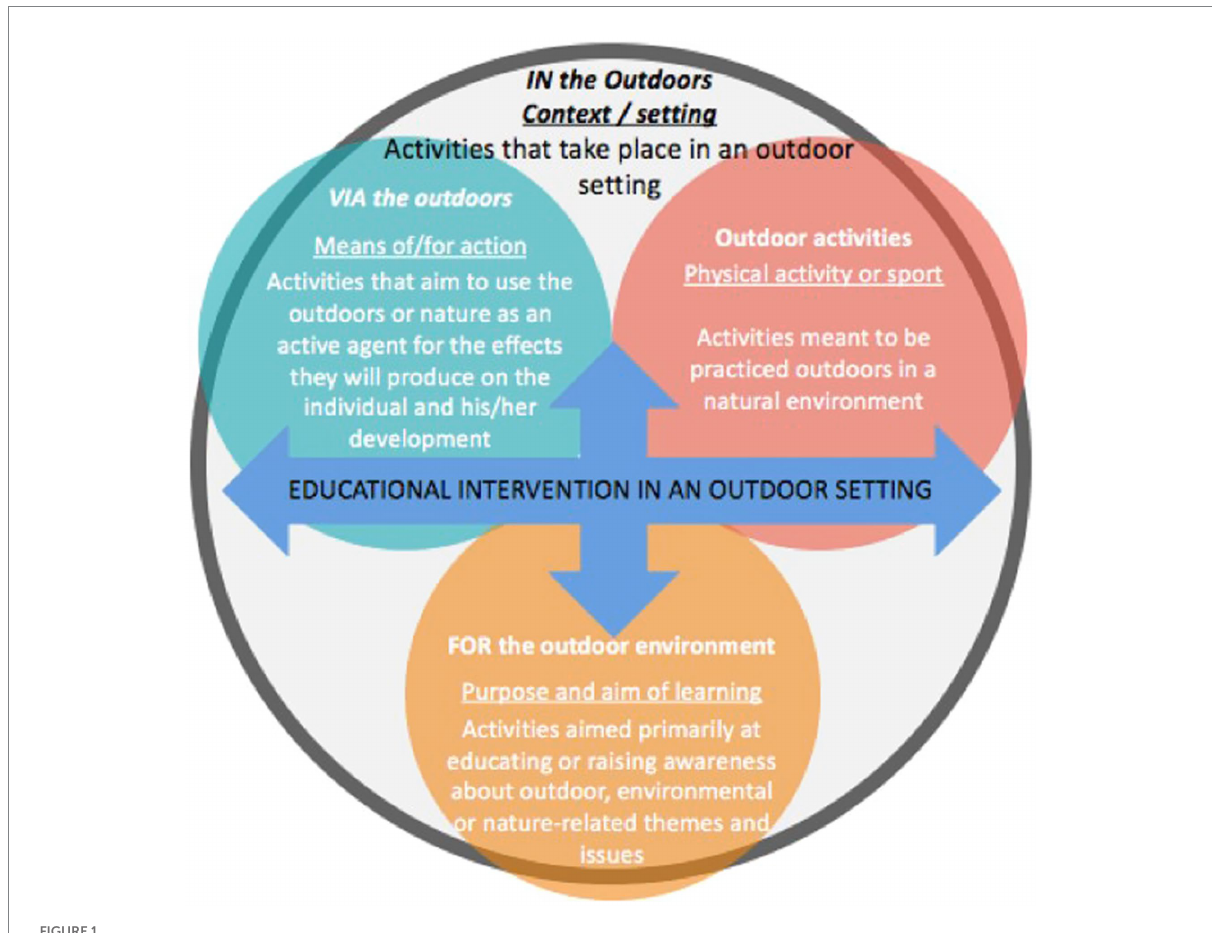
FIGURE 1 Intentions to use the outdoors by Gadais et al.